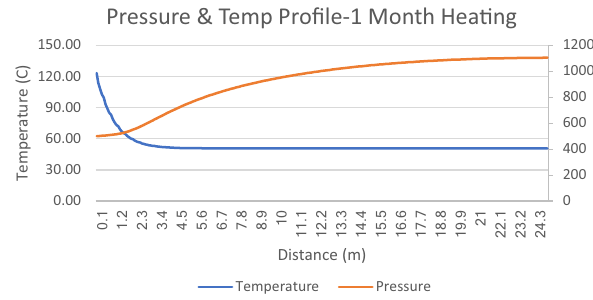
Fig. 6 Constant flowrate pressure and temperature profile